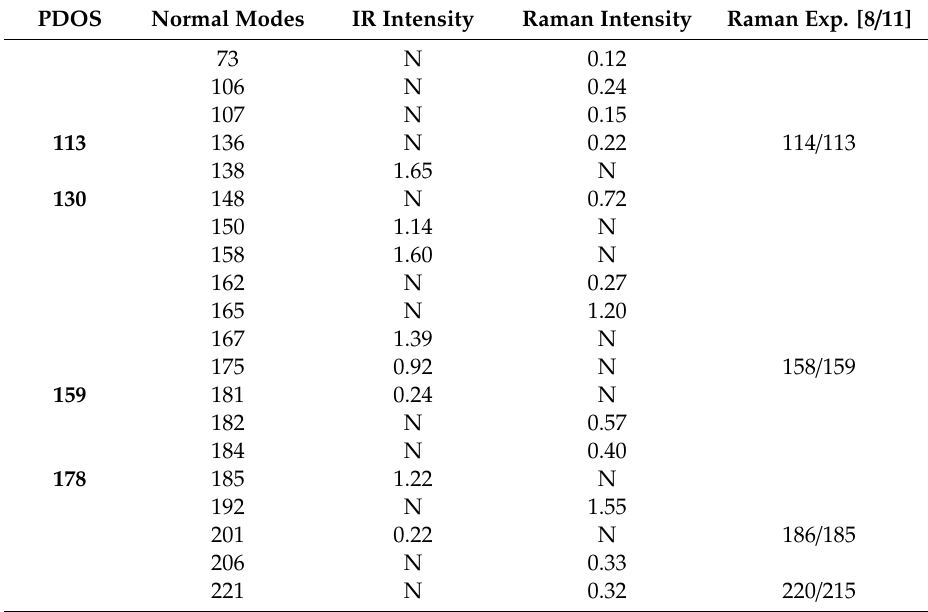
Figure 1. Computational spectra of Raman, IR, and phonon density of states (PDOS) of ice XV. Four vibrational bands: ( a ) intermolecular translation band; ( b ) intermolecular libration band; ( c ) intramolecular bending band; and ( d ) intramolecular stretching band. Table 1. Comparison of calculated results with Raman data. The normal modes (0.9 GPa) with IR / Raman intensities are compared with experimental Raman peaks. N means Raman inactive. PDOS, phonon density of states.